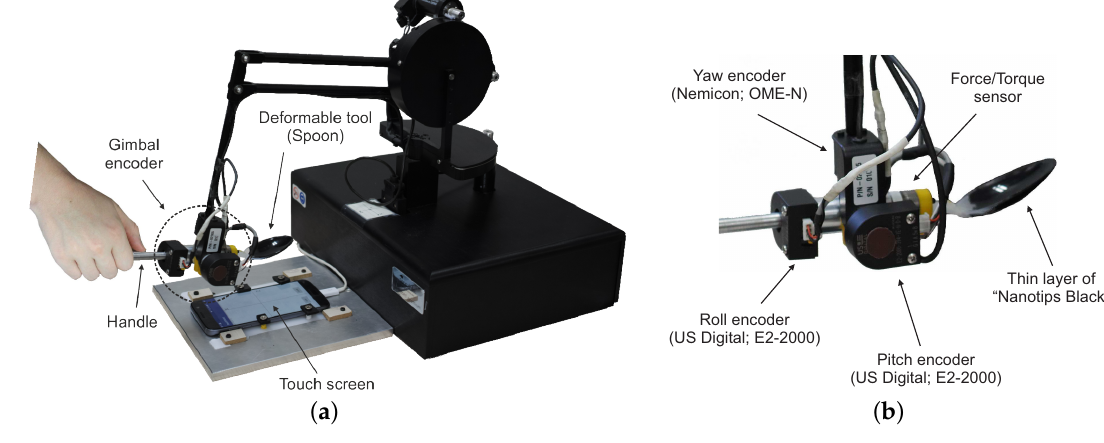
Figure 4. Data recording setup. A user holds the handle of the device and presses the tool to surface of the touchscreen. Data from the tool deformation is recorded when the tool is in contact with the touchscreen. ( a ) Recording hardware; ( b ) Gimbal